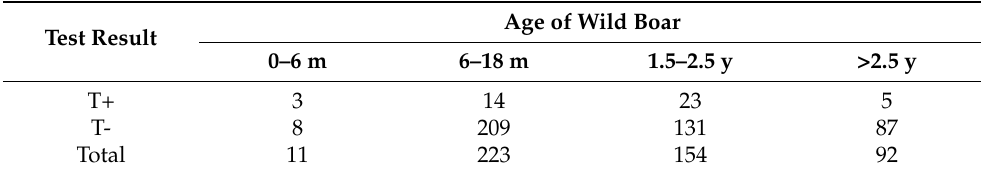
Table 6. The results of c-ELISA stratified by age.